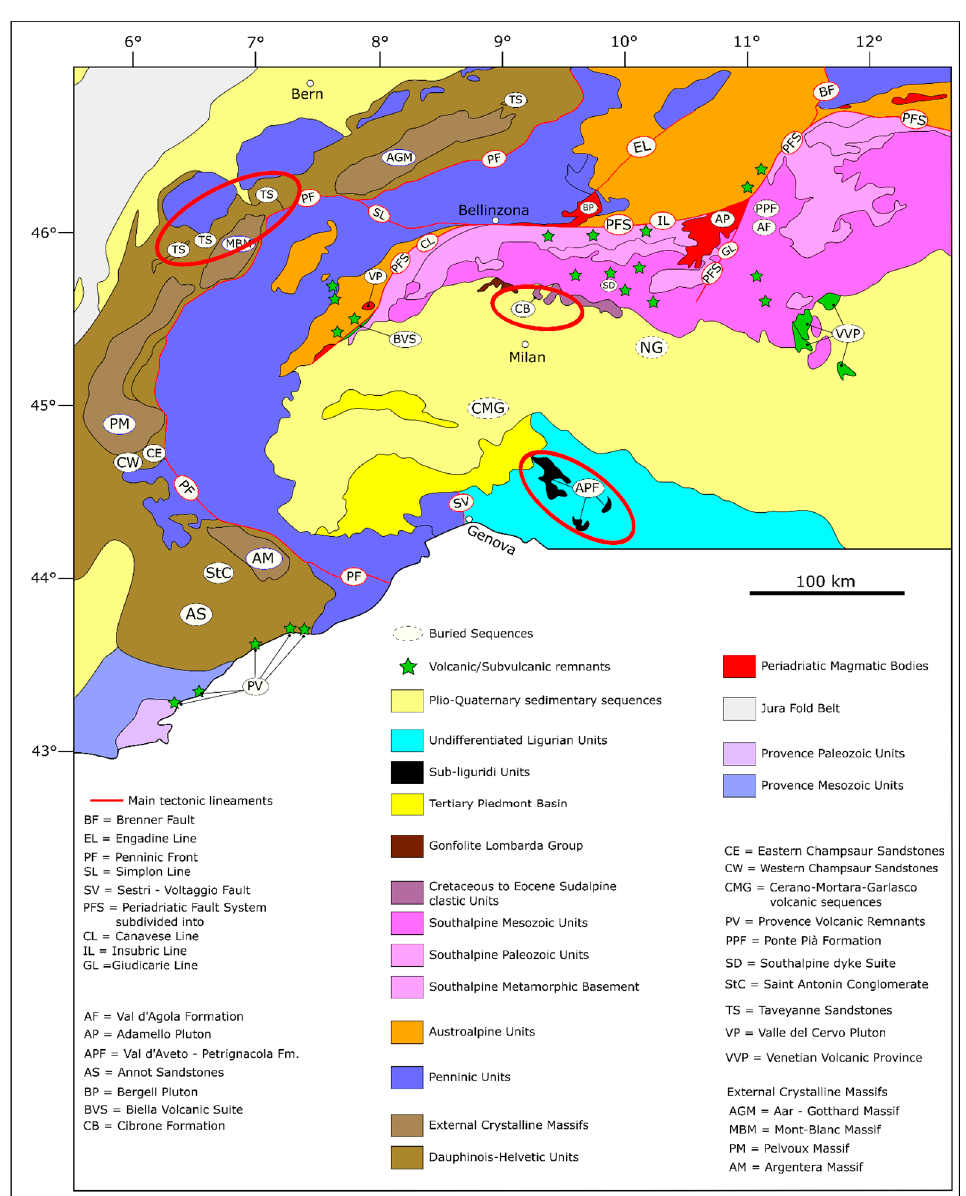
Figure 1. Regional Geological Maps of the Alps and Northern Apennines modified from [18]. The Formations object of this review are circled by red